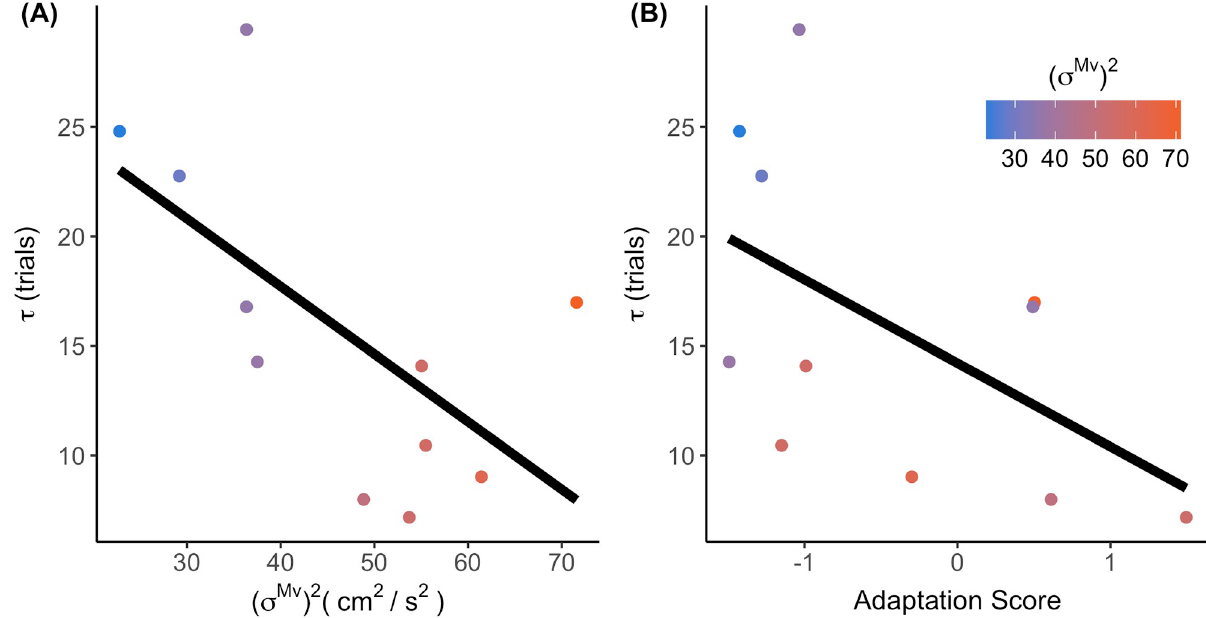
Fig 4. Verification of the adaptation score. A. The relation between movement speed variability and τ of the exponential function. B. The relationship between the Adaptation Score and τ of the exponential function.